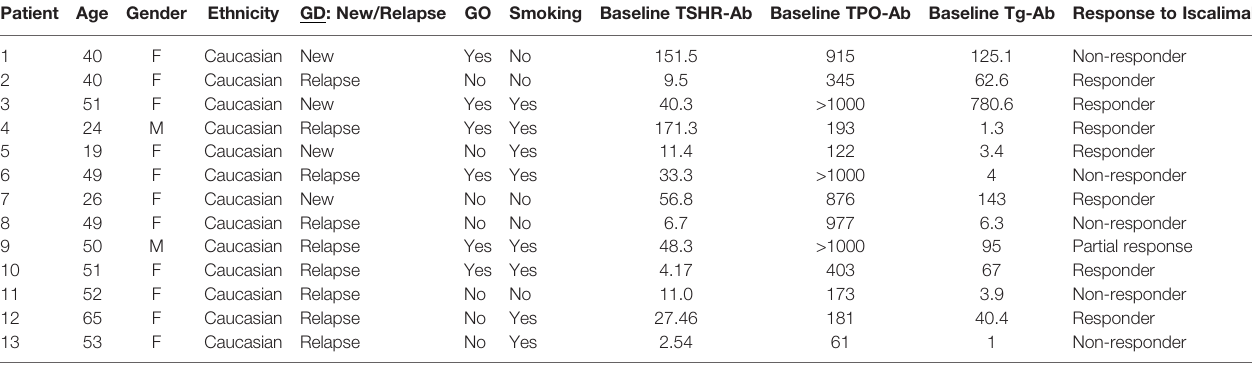
TABLE 2 | Characteristics of the cohort of Graves ’ disease (GD) patients analyzed in the